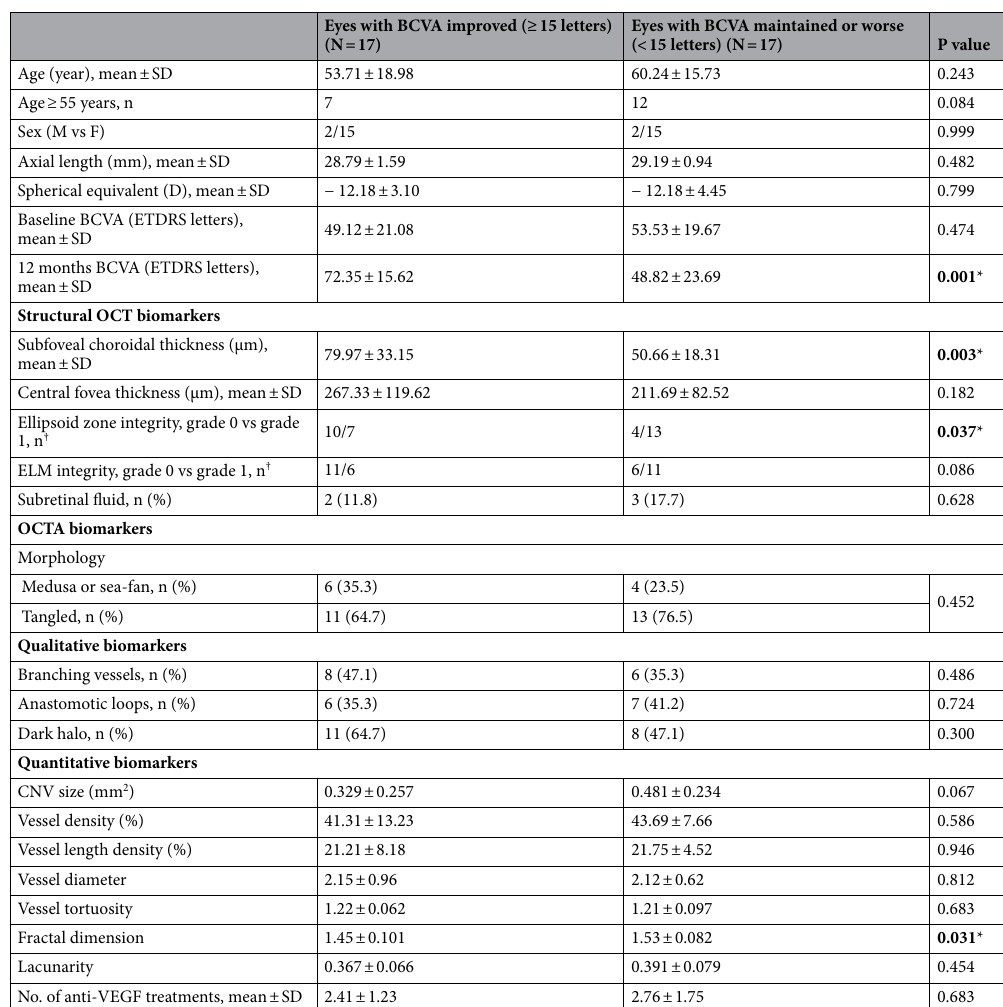
Table 1. Comparison of clinical characteristics between BCVA improved ≥ 15 letters and < 15 letters among choroidal neovascularization in myopic eyes. anti-VEGF: anti- anti-vascular endothelial growth factor; BCVA: best corrected visual acuity; CNV: choroidal neovascularization; D: diopters; ELM: external limiting membrane; No.: numbers; OCT: optical coherence tomography; OCTA: OCT angiography; SD: standard deviation. † Ellipsoid zone integrity and ELM integrity were evaluated as the means of the horizontal and vertical scans and graded as: 0 (intact or mild disruption < 1/2 within the central 1 mm), 1 (severe disruption > 1/2 within the central 1 mm). *Statistically significant (P <